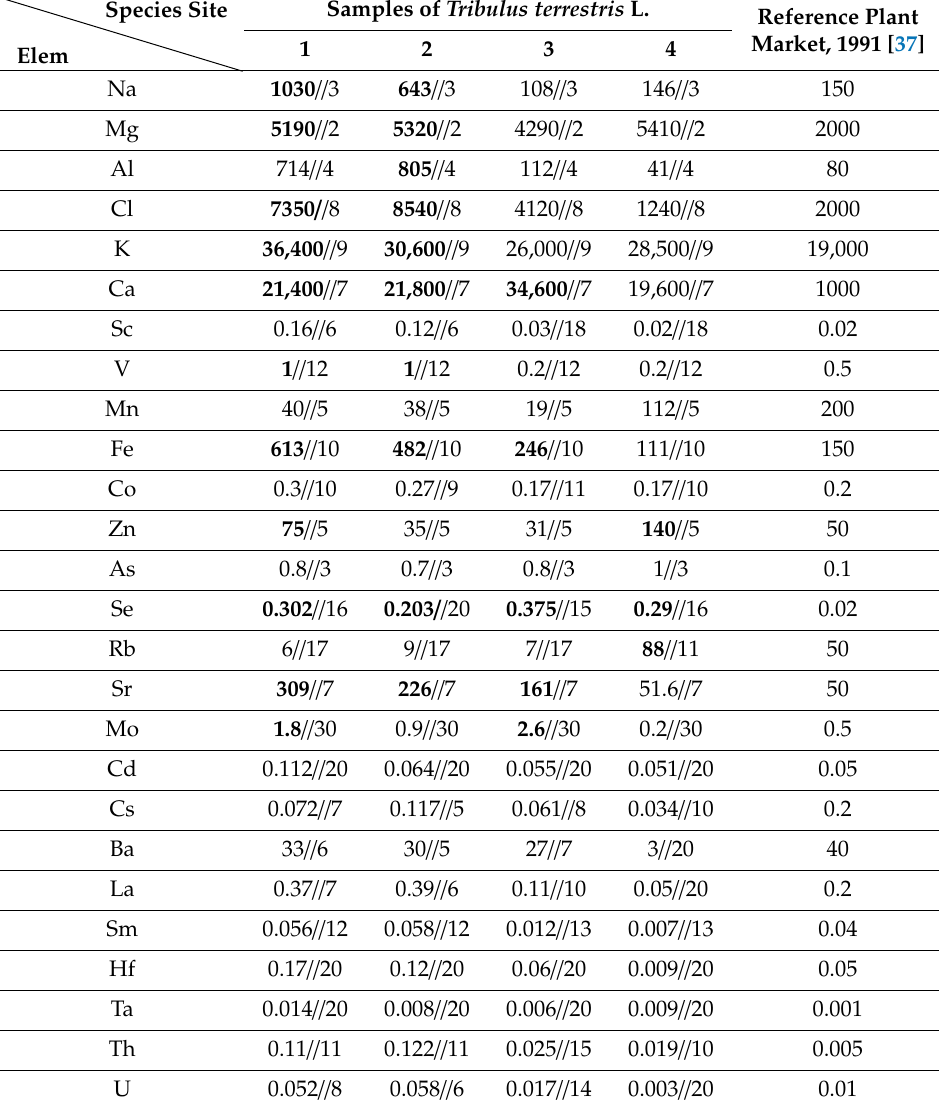
Table 2. Concentration of the main elements (mg / kg // σ , %) in the